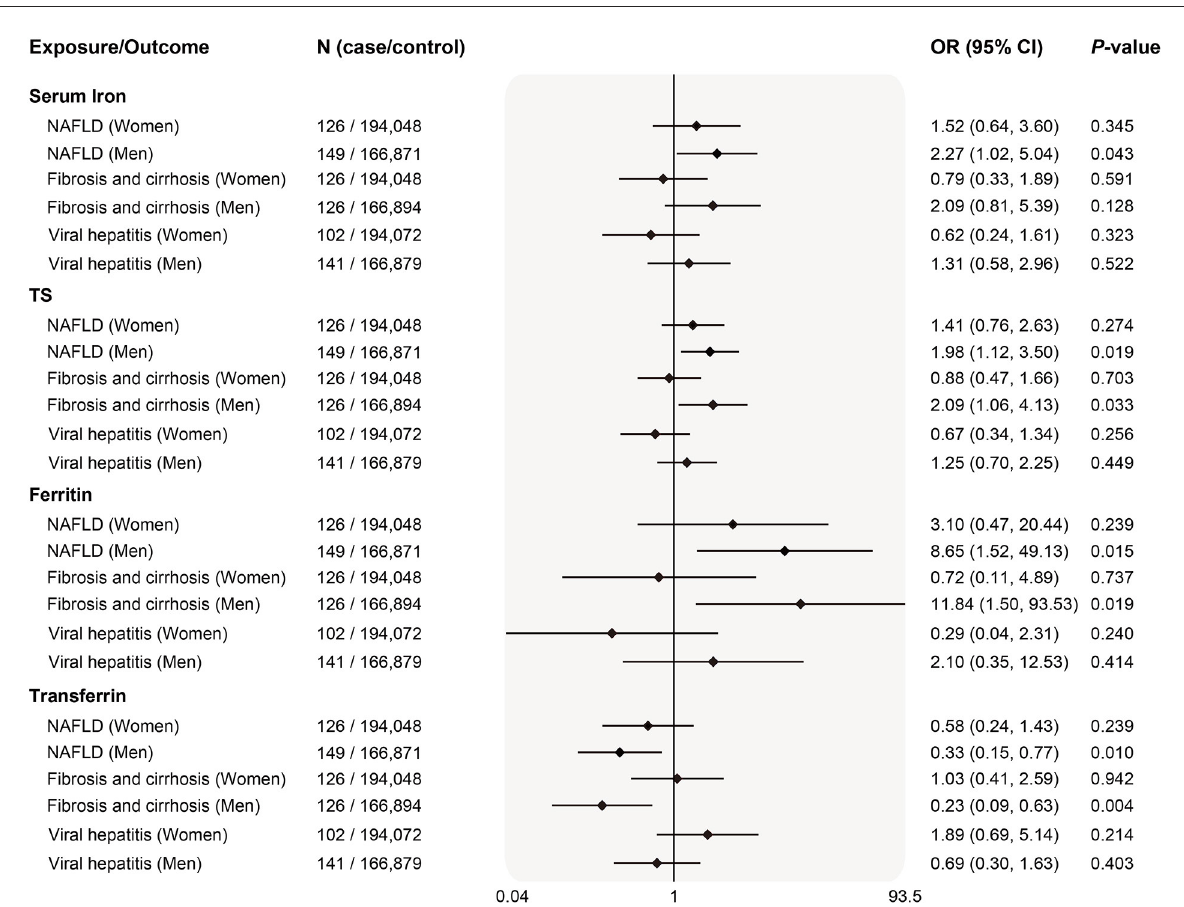
FIGURE4 Sex-specific associations of genetically predicted iron status and liver diseases. The OR (95% CI) of liver diseases (NAFLD, fibrosis and cirrhosis and viral hepatitis) by sex per SD increase of iron status biomarkers were estimated using fixed-effect inverse-variance weighted meta-analysis. OR, odds ratio; 95% CI, 95% confidence interval; NAFLD, nonalcoholic fatty liver disease; SD, standard deviation.